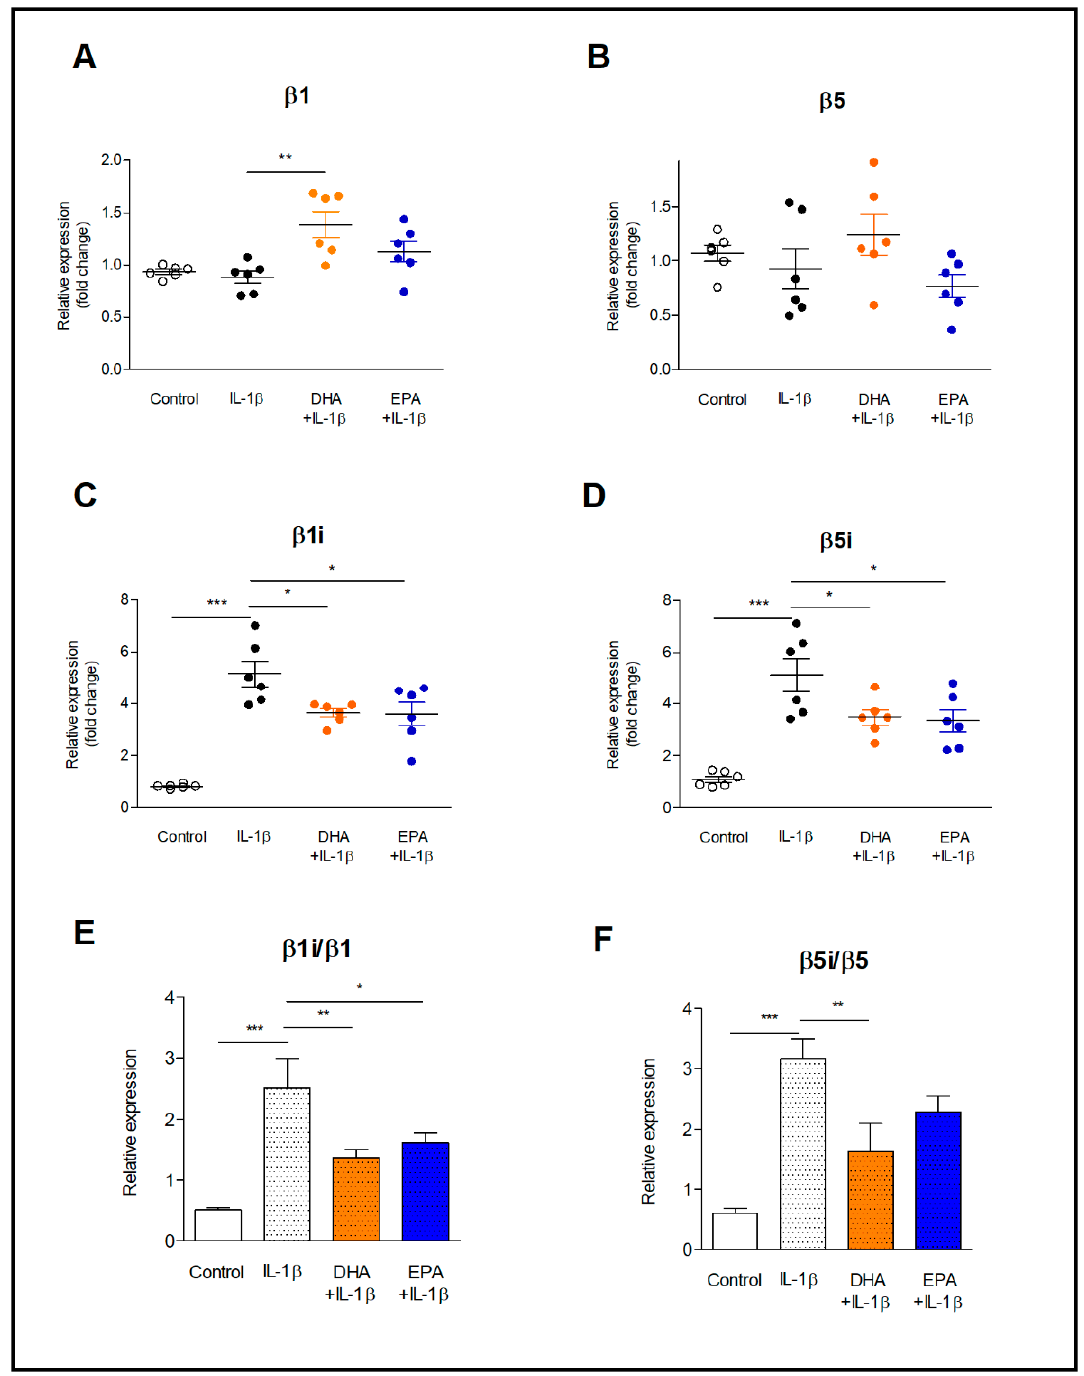
Figure 2. The effects of DHA and EPA on the constitutive and inducible 20S core subunit expression in astrocytes activated with IL-1 β . Astrocytes were incubated with DHA and EPA (30 µ M) for 24 h, followed by treatment with IL-1 β (10 ng/mL) for 16 h. Total mRNA was isolated from cells by Trizol and β 1 ( A ), β 5 ( B ), β 1i ( C ) and β 5i ( D ) subunits expression was determined by quantitative real-time PCR. The ratios of inducible to constitutive proteasome subunits β 1i/ β 1 ( E ) and β 5i/ β 5 ( F ) expression were calculated. * p < 0.05, ** p < 0.01, *** p < 0.001.